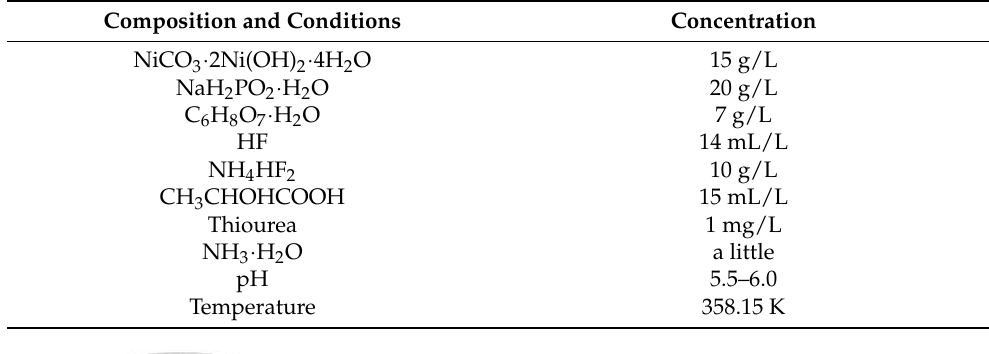
Table 2. The composition and conditions of the electroless Ni–P plating bath for magnesium– lithium alloys.